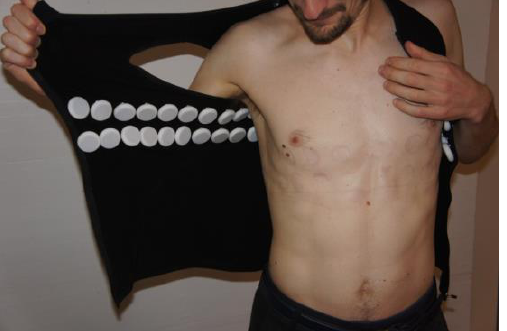
Figure 12. Final implementation of 50 cooperative sensors in a vest for measuring multilead ECG and